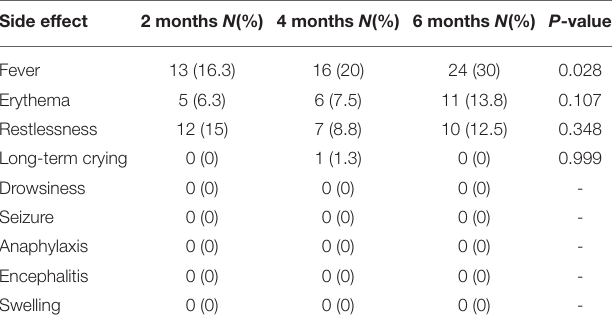
TABLE 3 | Adverse events associated with Pentavalent vaccination in different ages. Side